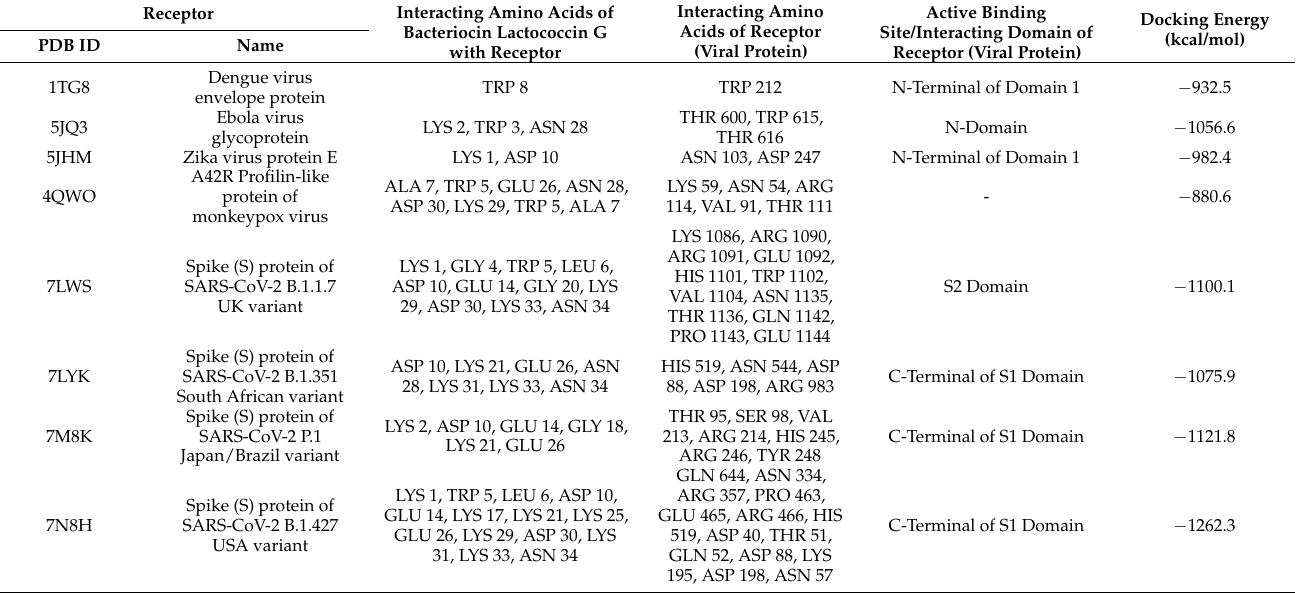
Table 4. Molecular docking analysis of bacteriocin lactococcin G (PDB ID: 2JPK) derived from L. lactis